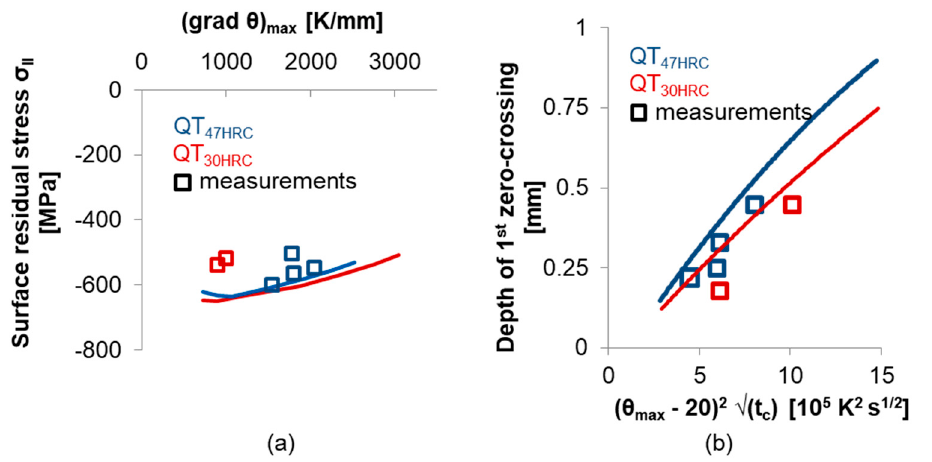
Figure 11. ( a ) Comparison of simulated and measured data for surface residual stresses and ( b ) 1st zero-crossings.